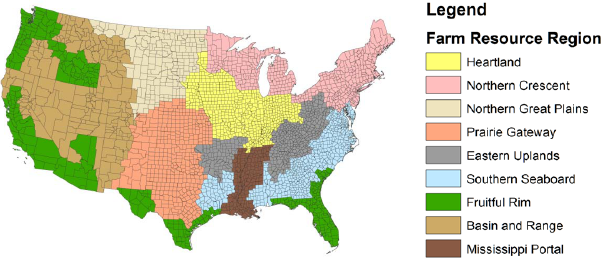
Fig. 3. Farm Resource Regions were defined by USDA (2000) to represent geographic specialization in production of US farm com- modities. These regions are used to aggregate county-level results in our analysis.